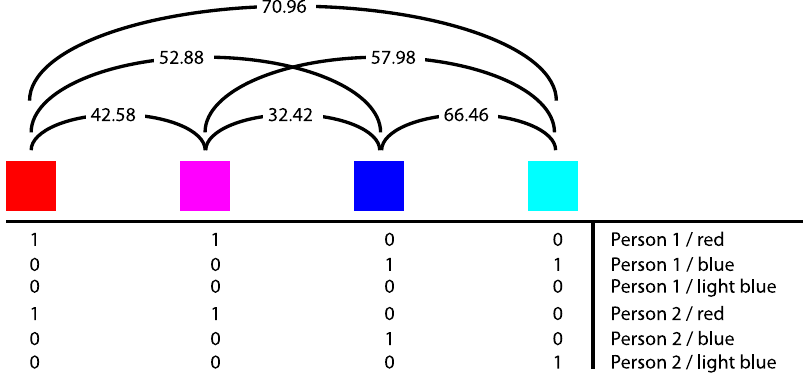
Figure 2. The two layers of data used here. At the top, we see a sample of four colors, as well as the CIE L*a*b* D E distances between all pairs among these colors. Below, we see a hypothetical sequence of color naming responses. Various papers by Kay and coauthors [2,8,17] pick out a best representative point in the space above and replace any distribution below with this single representative. Lindsey & Brown [4] point out that this approach, by ignoring most of the structural information contained in the concrete distributions in the data below loses significant information about color naming systems and patterns. Lindsey & Brown and Ja¨ger [9] on their hand focus on the distributions of responses in the lower part of this figure, ignoring completely the perceptual distances in the color space above. In this paper, we argue that a better way is to work with methods that include both layers of the data: that work both with the perceptual distances above and the distributions below.